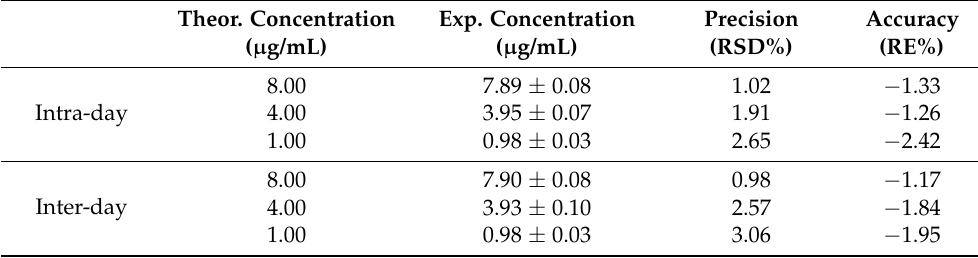
Table 3. Intra-day and inter-day accuracy and precision of RB (means ± SD, n = 6).